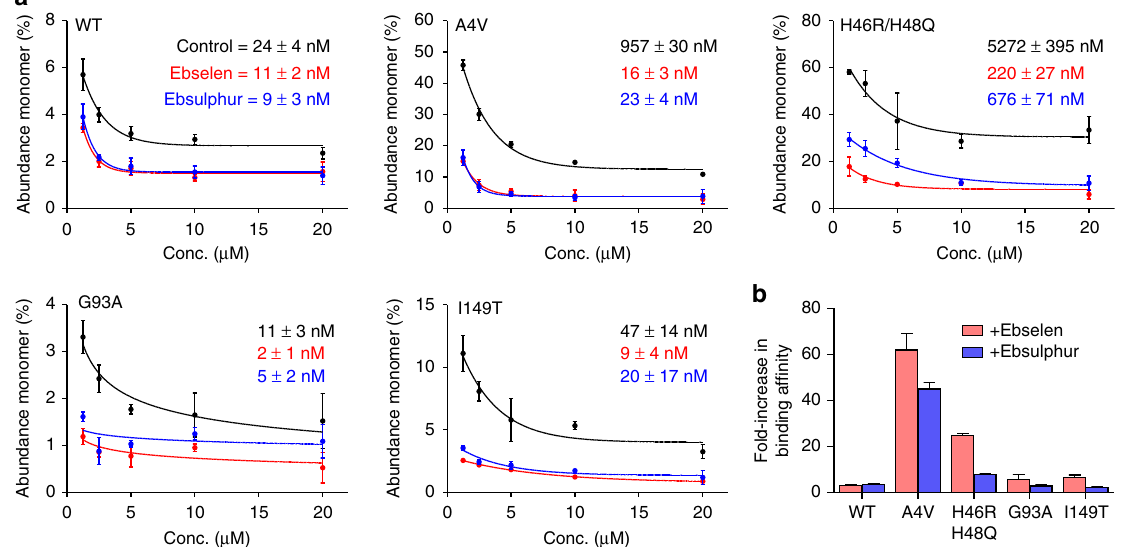
Fig. 2 Conjugation of ebselen and ebsulphur to SOD1 variants increases the binding af fi nity of the dimer. a SOD1 variants (wild-type, A4V, H46R/H48Q, G93A and I149T) with ebselen (red), ebsulphur (blue) and without treatment (black) were buffer exchanged into 200 mM NH 4 OAc and subjected to nanoESI mass spectrometry at different protein concentrations under gentle conditions optimized to maintain non-covalent interactions. Curves show the percentage of monomer signal as a function of protein concentration with determined dimer K d values inset for each SOD1 variant. Error bars represent the standard deviation of three replicates. b The fold-increase in binding af fi nity of each SOD1 variant when ebselen or ebsulphur is conjugated at Cys111 where error bars represent the upper and lower K d values calculated in